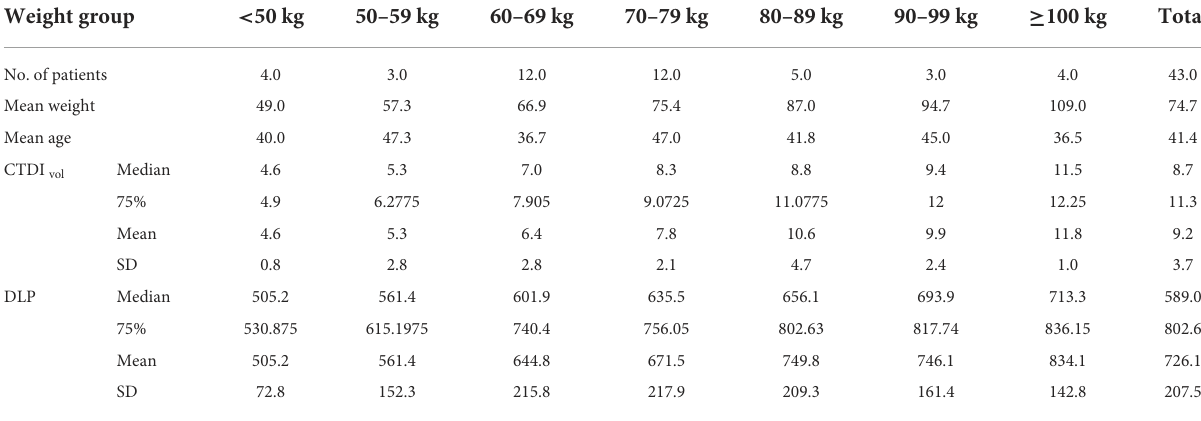
TABLE 6 Distribution of abdomen and pelvis without contrast CT for patients in different weight